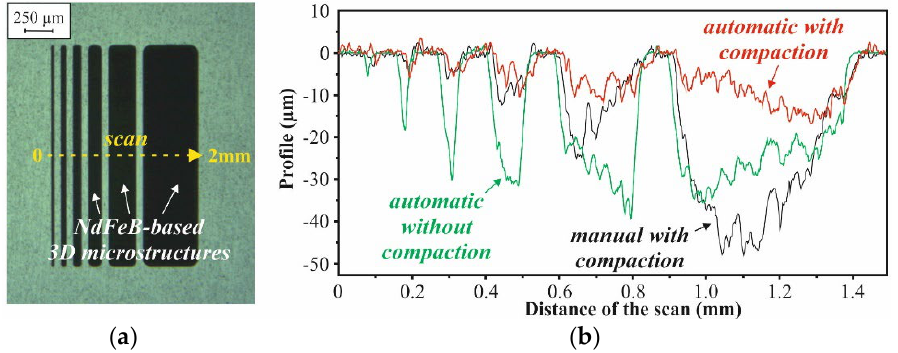
Figure 21. ( a ) Photograph of a chip of design M5 with an array of 2-mm-long 3D microstructures with 25, 50, 75, 125, 250 and 500 µm width (from left to the right) and ( b ) exemplary profilometer scans over chips from substrates processed using different mold filling procedures. The gap between neighboring structures is 60 µm.